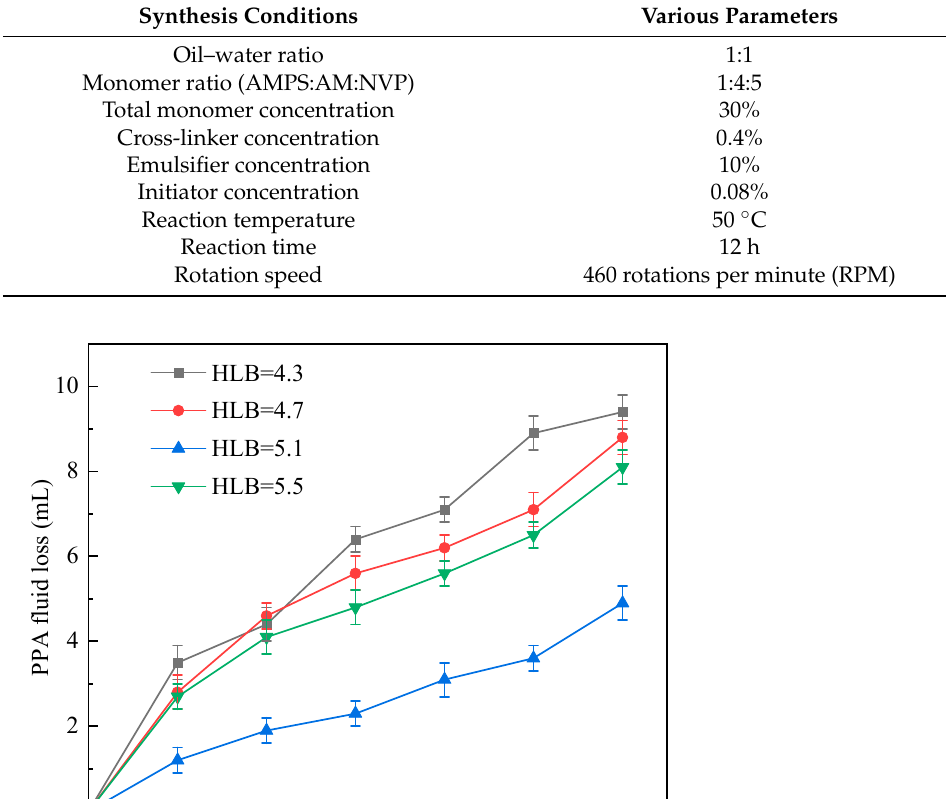
Table 1. The synthesis conditions of AMN other than HLB.